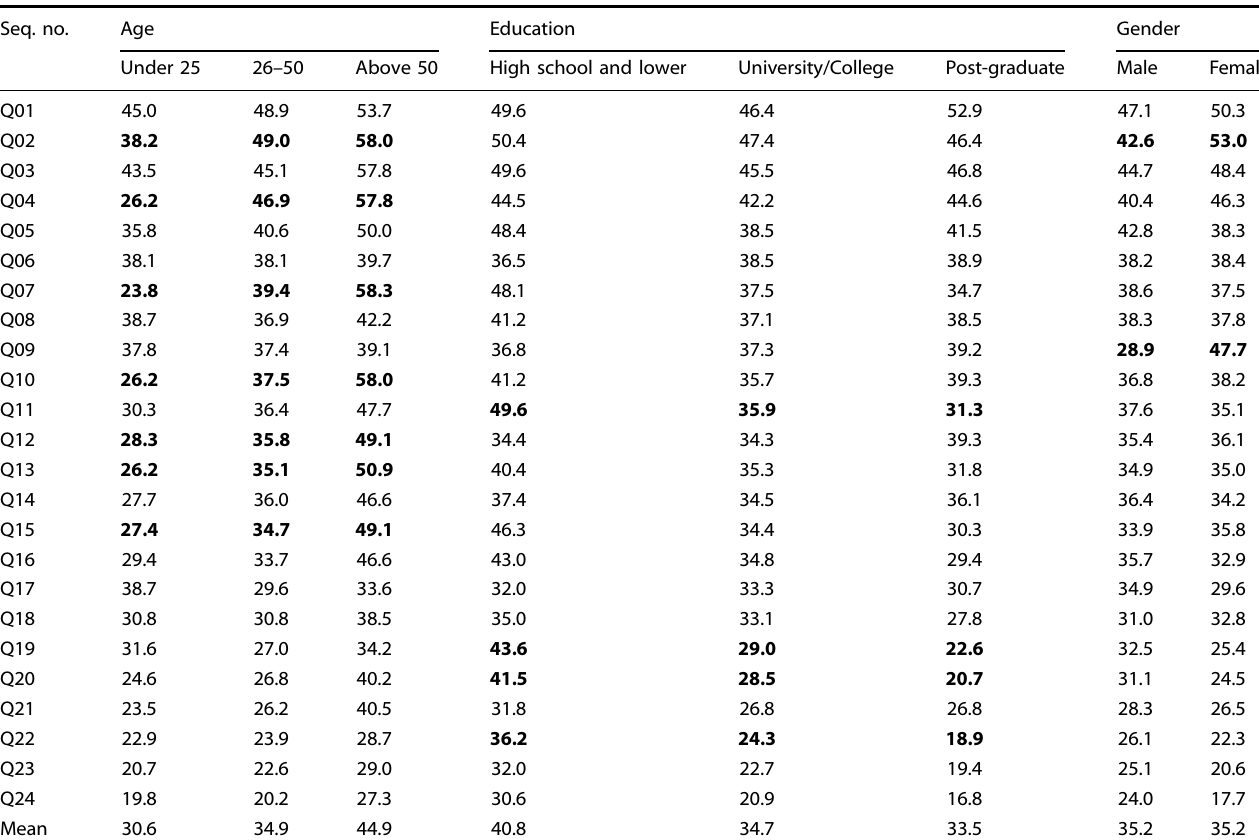
Table 3. Demographic analysis of interest